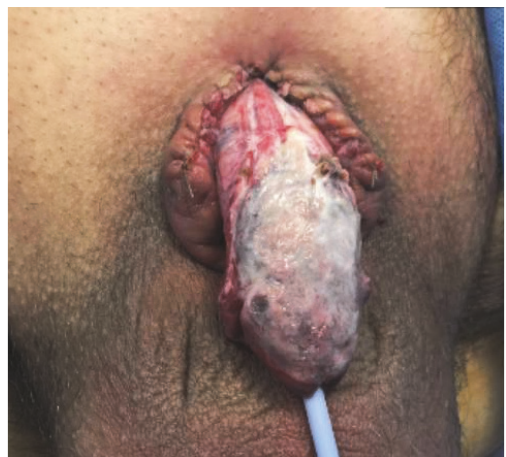
Figure 4: Necrotic tissue of the dorsal glans and shaft following initial irrigation and